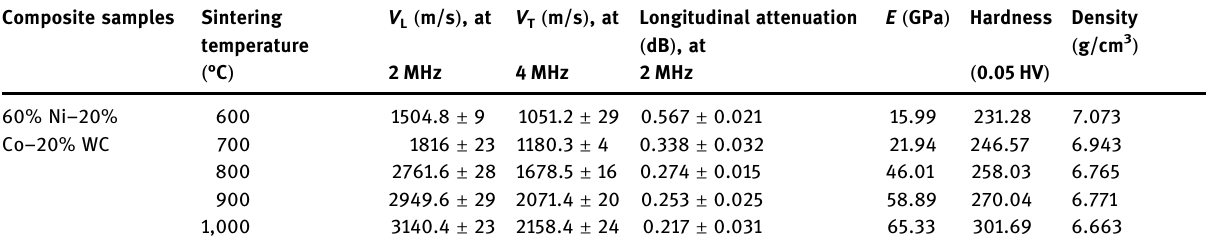
Table 1: Physical and mechanical properties and sintering temperature of Ni – Co – WC ceramic – metal composites Composite samples